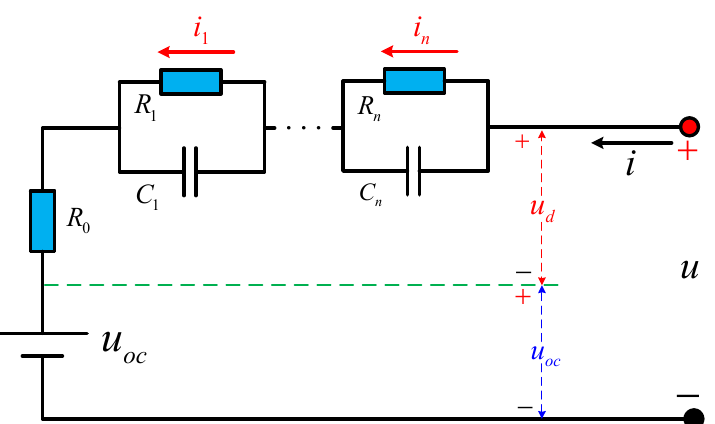
Figure 7. Equivalent circuit model with